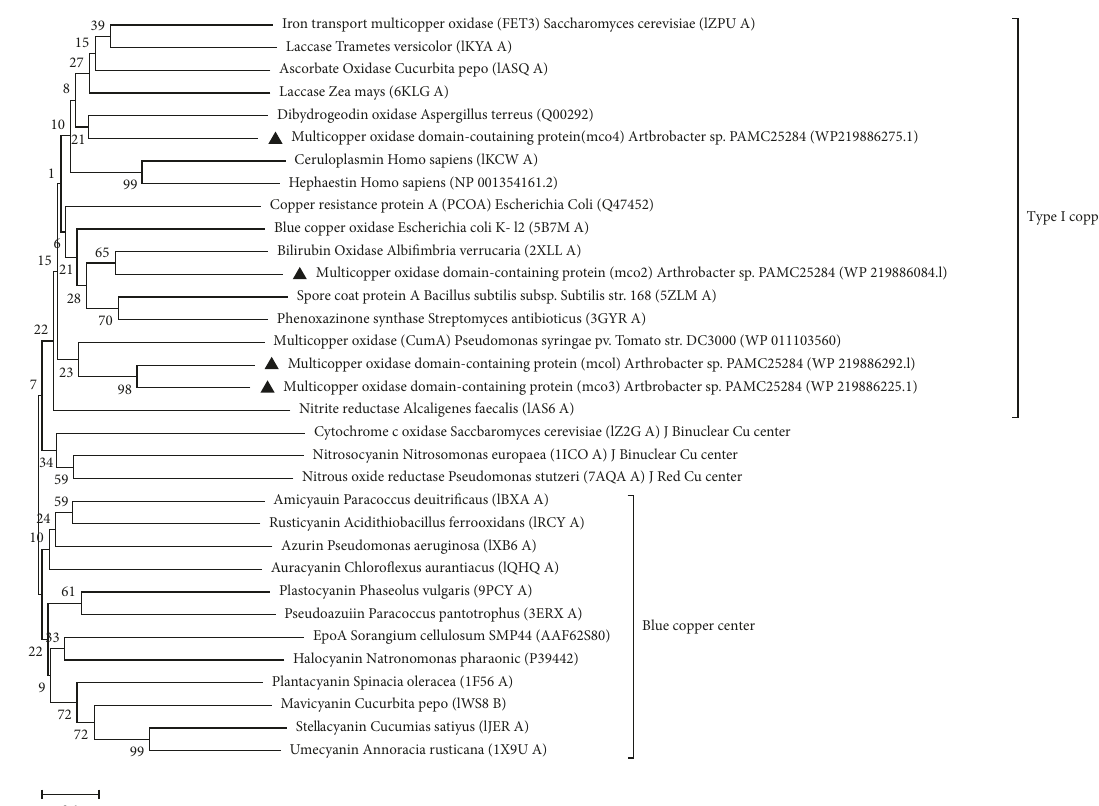
Figure 3: Neighbor joining phylogenetic tree based on multi-copper oxidase domain-containing protein sequences (indicated in triangles) of strain PAMC25284 and type I copper center protein gene sequences. The numbers at the nodes indicate the level of bootstrap support based on a maximum likelihood of 1,000 resampled datasets. Scale bar 0.10 substitutions per nucleotide position. Accession numbers or (cid:31) protein structure numbers of the sequences are indicated in